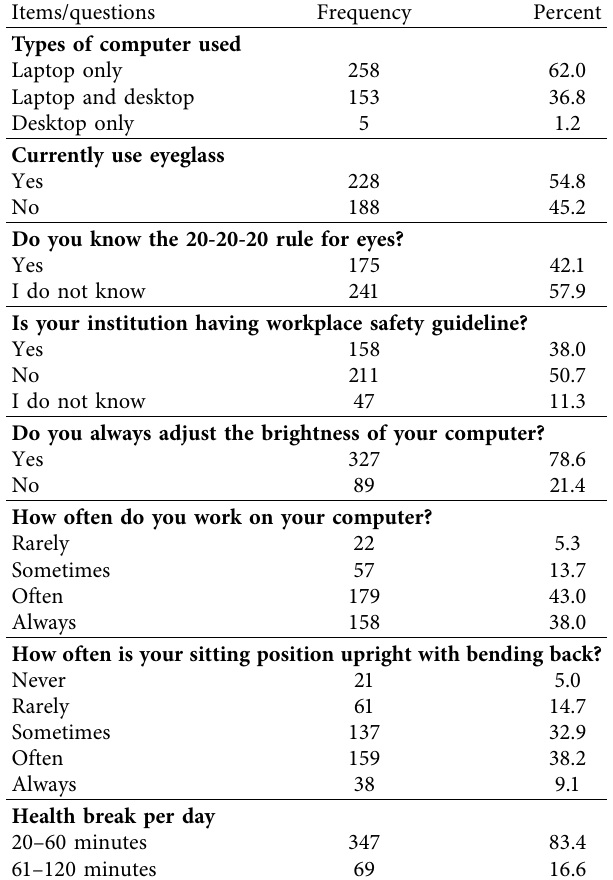
Table 1: Sociodemographic characteristics of instructors in Ethi- opian universities, 2021 ( n � 416).